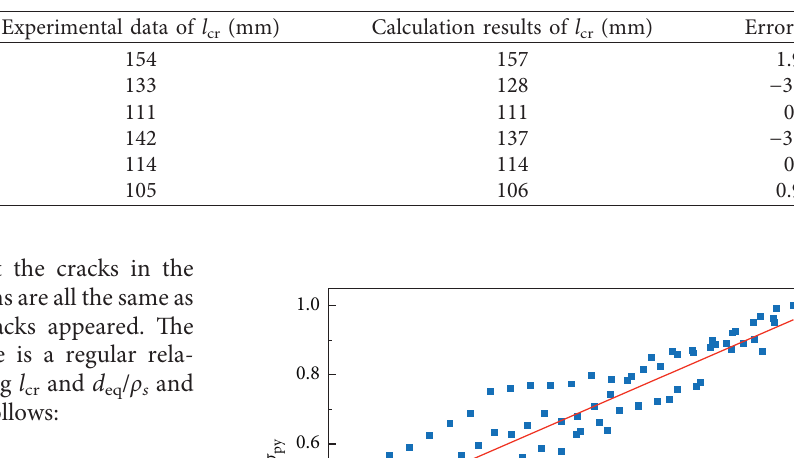
Table 6: Calculation results and experimental data of mean crack spacing.